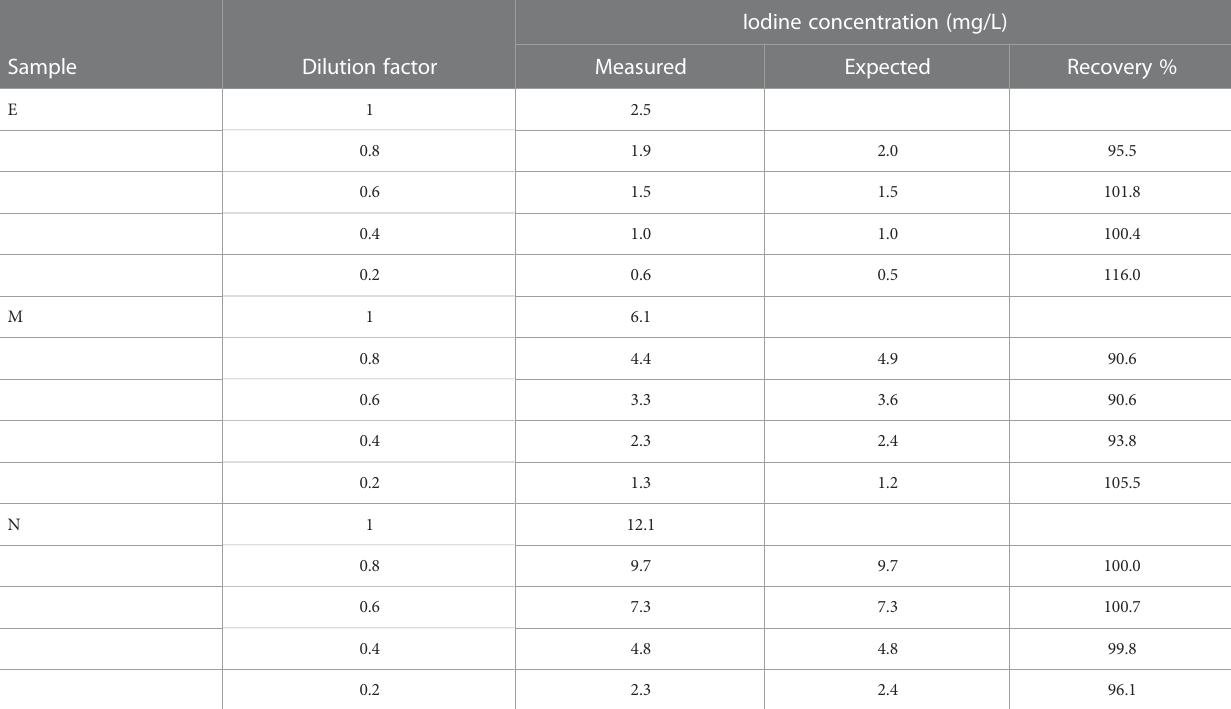
TABLE 3 Serial dilution of soy sauce samples within